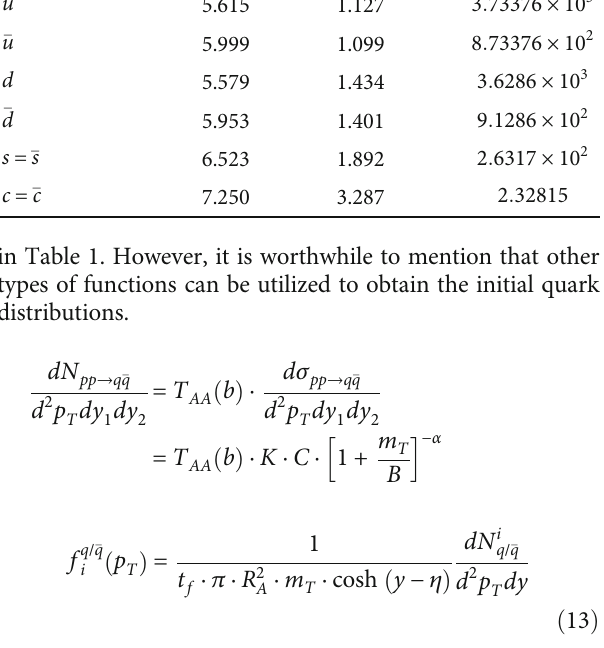
Table 1: Extracted parameters of equation (11) at LO pQCD calculations of p + p collision at